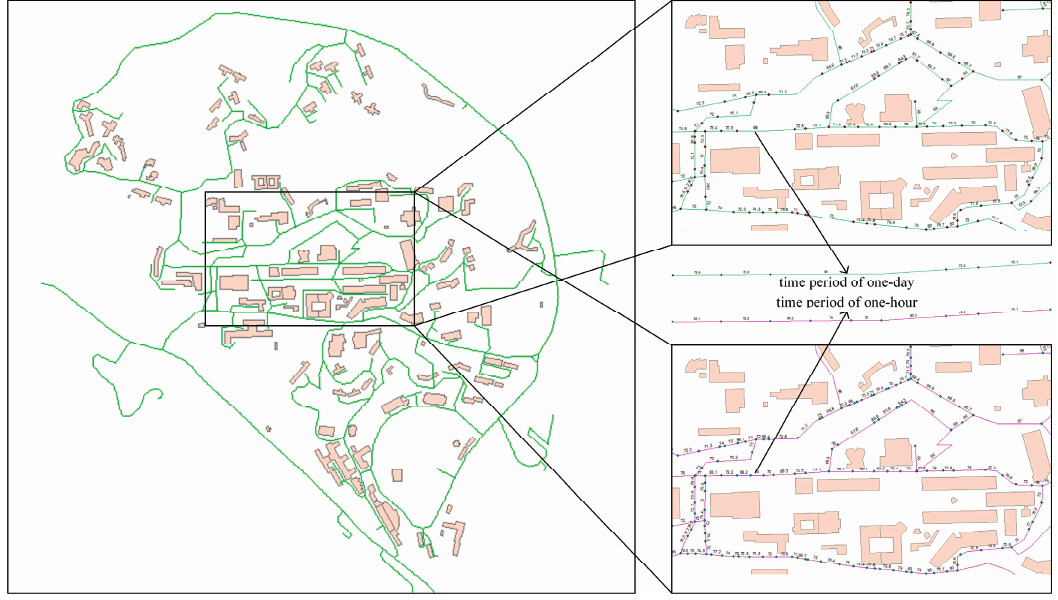
Figure 6. Demonstration of dynamic partitioning of the road segment on two different